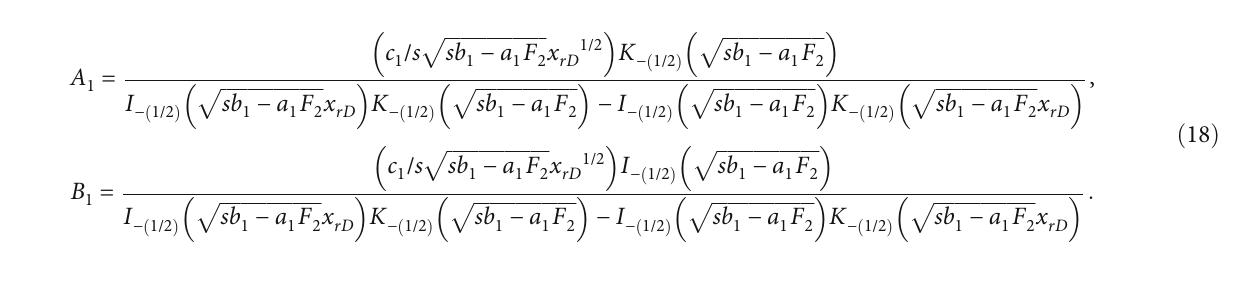
ffiffiffiffiffiffiffiffiffiffiffiffiffiffiffiffiffiffiffiffi p − a F sb 1 1 2